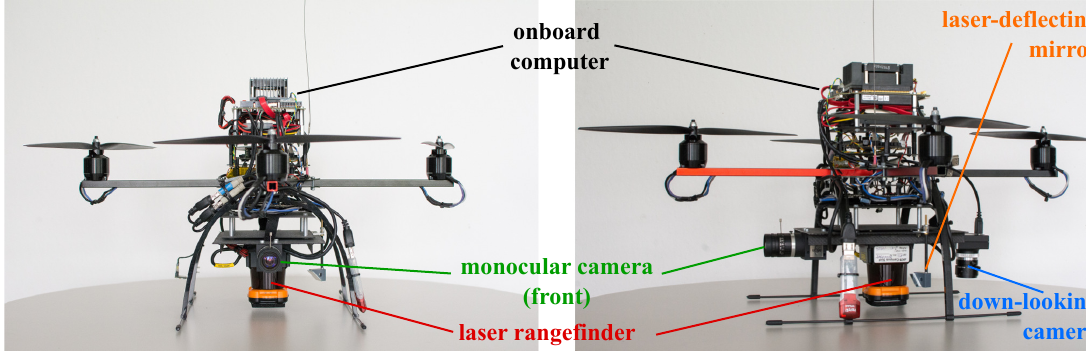
Figure 1. The Micro Air Vehicle (MAV) equipped with various